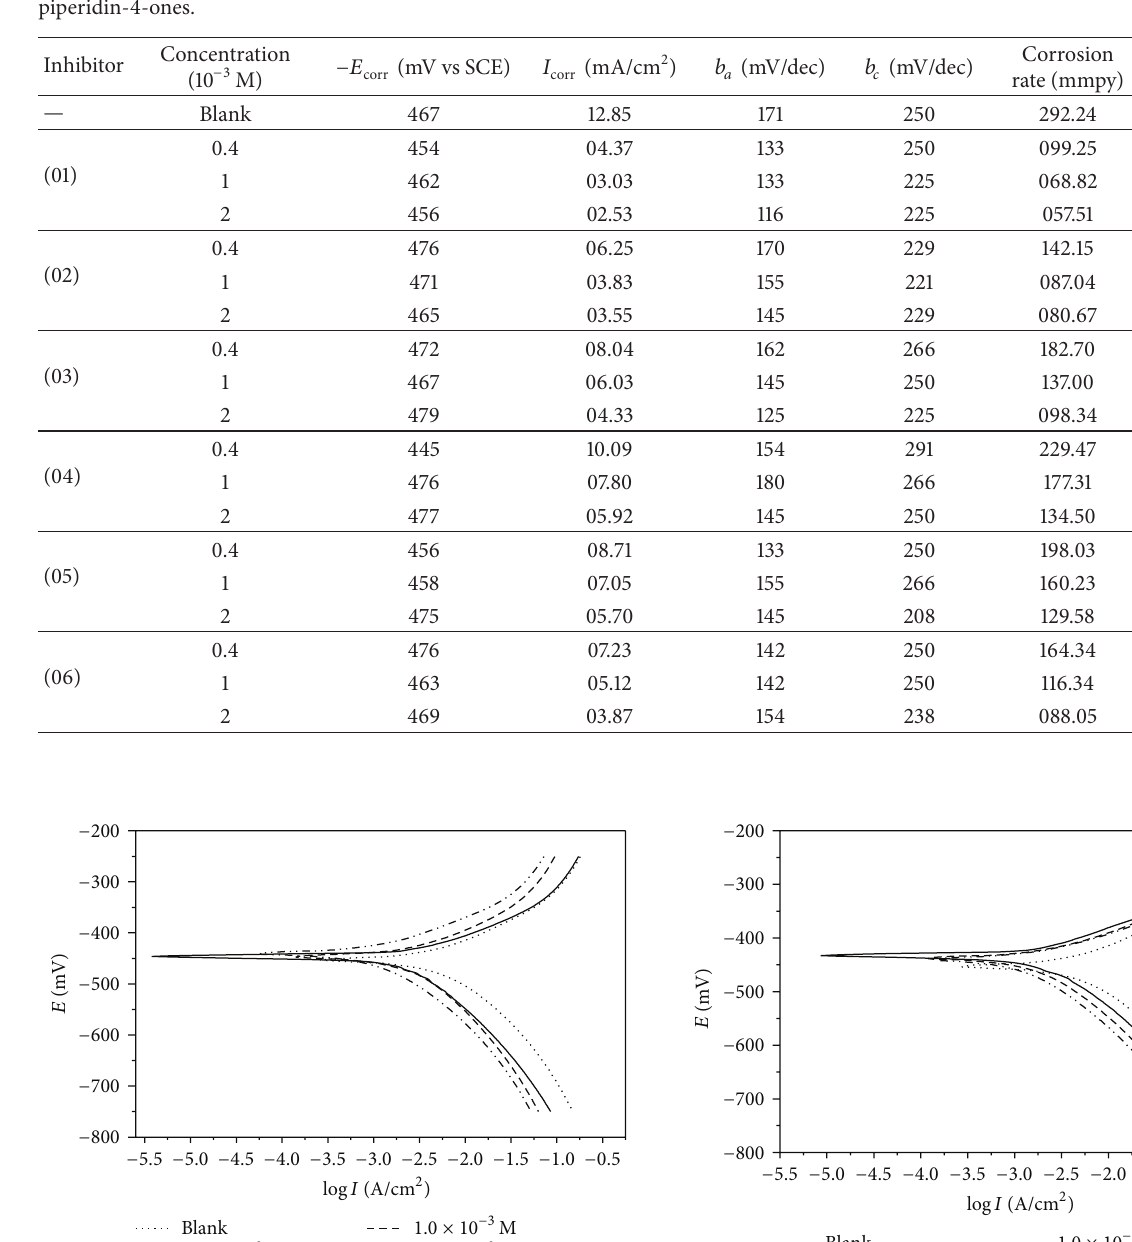
SO in the absence and presence of different concentrations of variously substituted 2 4